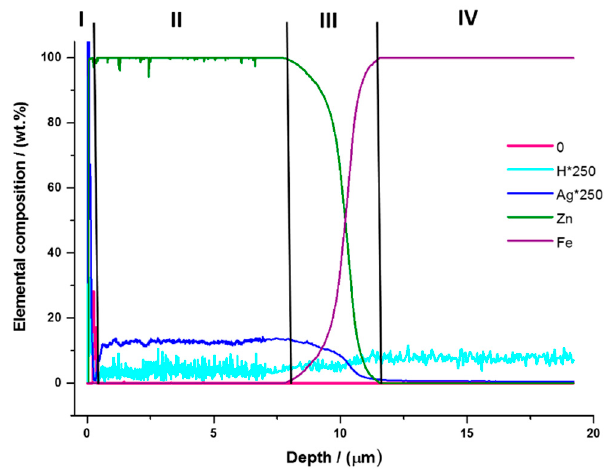
Figure 3. Typical GD-OES profile obtained from a Zn/AgP composite coating formed by applying 8.5 mA cm − 2 for 60 min a 25 °C.